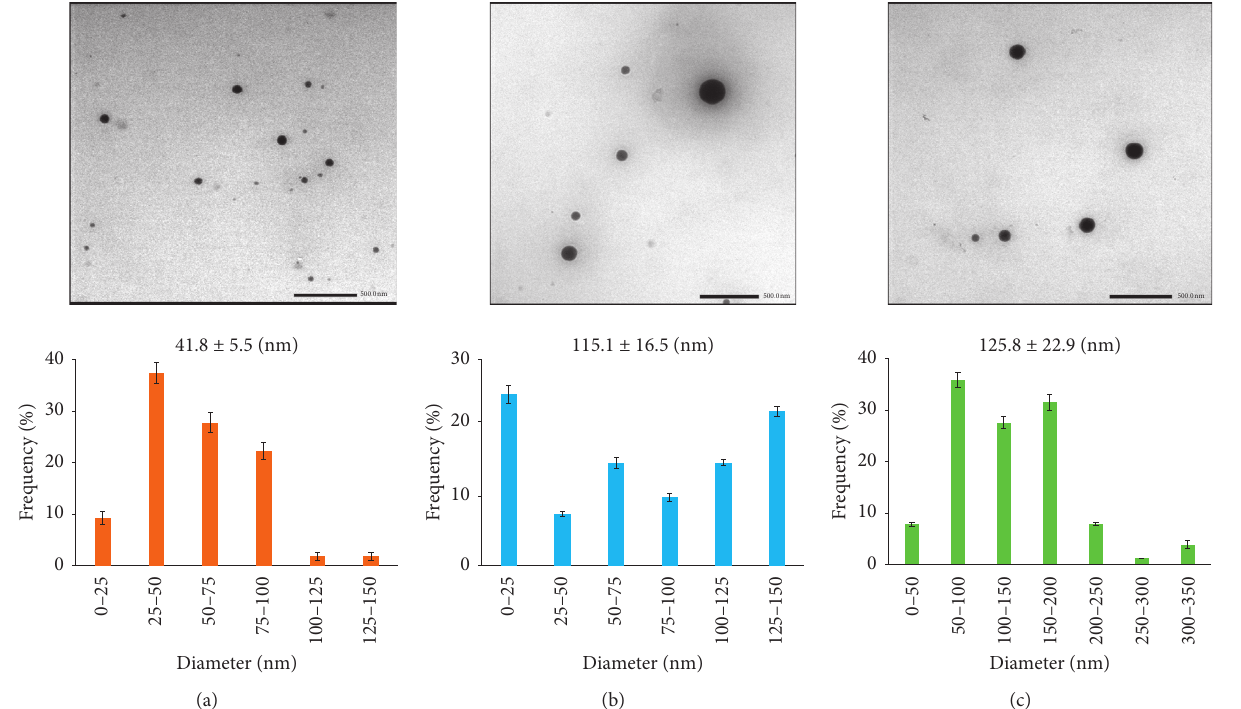
Figure 5: TEM images and size distribution of SeNPs/OCS stored at 27 ° C at different times: 0 days (a), 15 days (b), and 30 days (c).